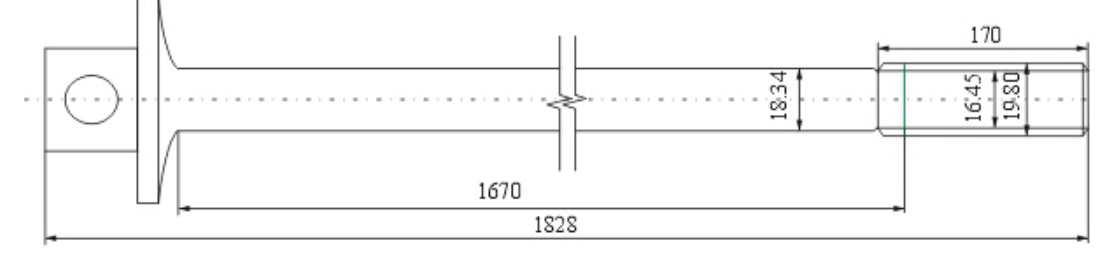
Fig. 9. Bolt rod – RS-2N